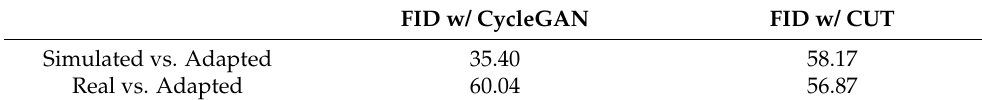
Table 3. Fréchet Inception Distances (FIDs) between the simulated/real domains and the domain adapted versions of the simulated images by CycleGAN and CUT. Lower FIDs mean closer distribu- tions, so CUT achieves better approximation to the real domain.